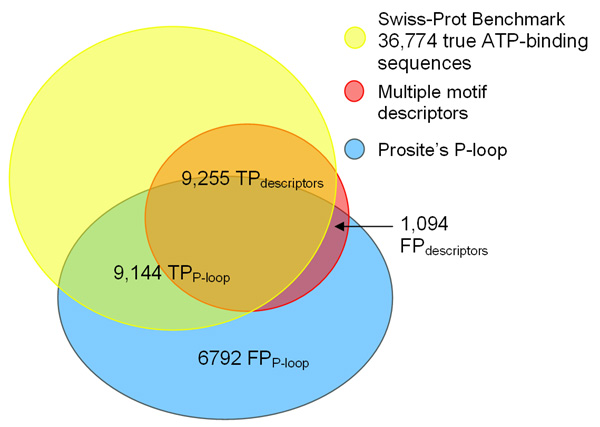
Validation of PLI-descriptors. Prediction of sequences annotated with the Swiss-Prot keyword „ATP-binding“ (or ATP/ADP as part of the catalytic activity) using Prosite patterns and multiple motif descriptors with hits below E-value 1: while both methods detect ~9.000 of all proteins annotated with this term by Swiss-Prot, Prosite provides almost sevenfold more false positives.